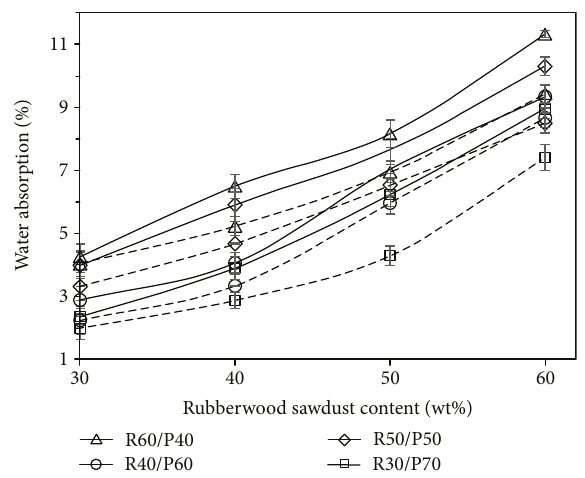
Figure 9: E ff ect of wood sawdust contents and sizes on water absorption for TPNR/RWS composites. Dashed lines show RWS 40 mesh, and solid lines represent RWS 80